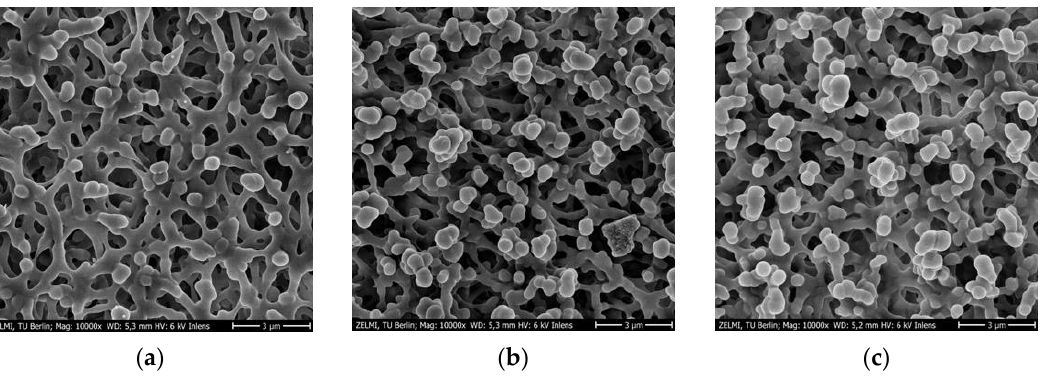
Figure 9. SEM micrographs at 10,000 × magnification of ( a ) bare PES membrane, ( b ) chitosan func- tionalized PES membrane before nanoMIP immobilization, and ( c ) chitosan functionalized PES membrane after nanoMIP immobilization.